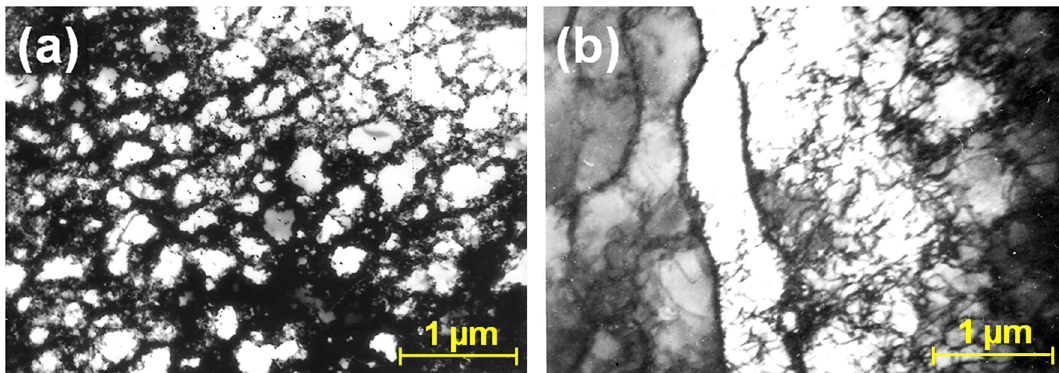
Figure 5. Dislocation structure in fractured specimens of AISI 316 steel: (a) 400°C and ε̇= 3.5 x 10 -4 s -1 ; (b) 700°C and ε̇= 3.5 x 10 -4 s -1